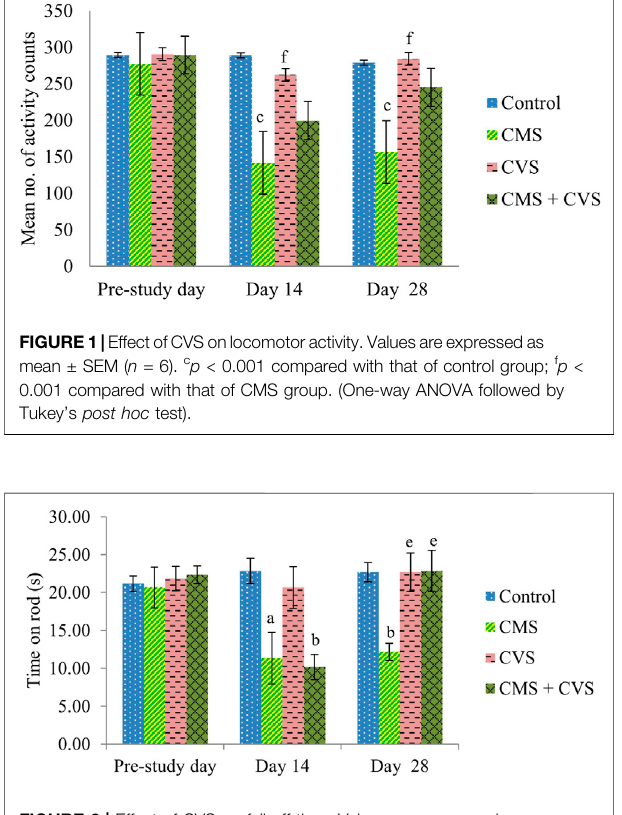
FIGURE 2 | Effect of CVS on fall off time. Values are expressed as mean±SEM( n =6). a p < 0.05, b p < 0.01comparedwiththatofcontrolgroup; e p < 0.01 compared with that of CMS group. (One-way ANOVA followed by Tukey ’ s post hoc test).